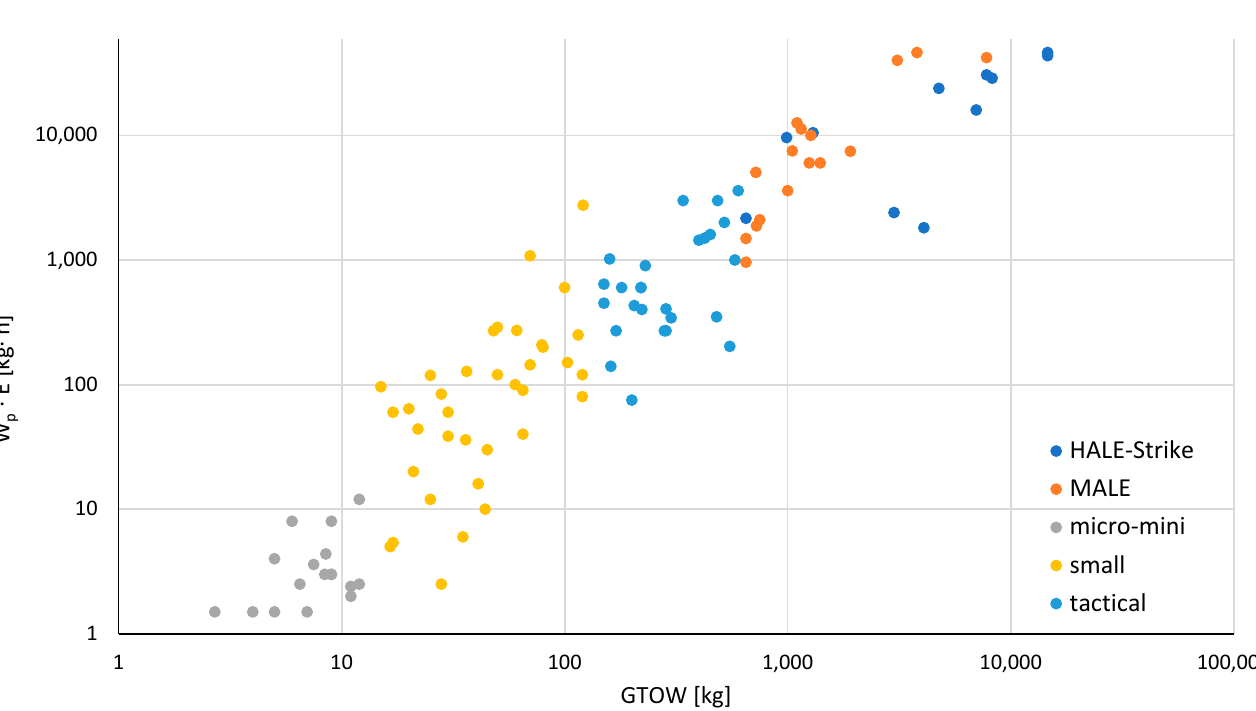
Figure 17. W p · E as a function of GTOW.